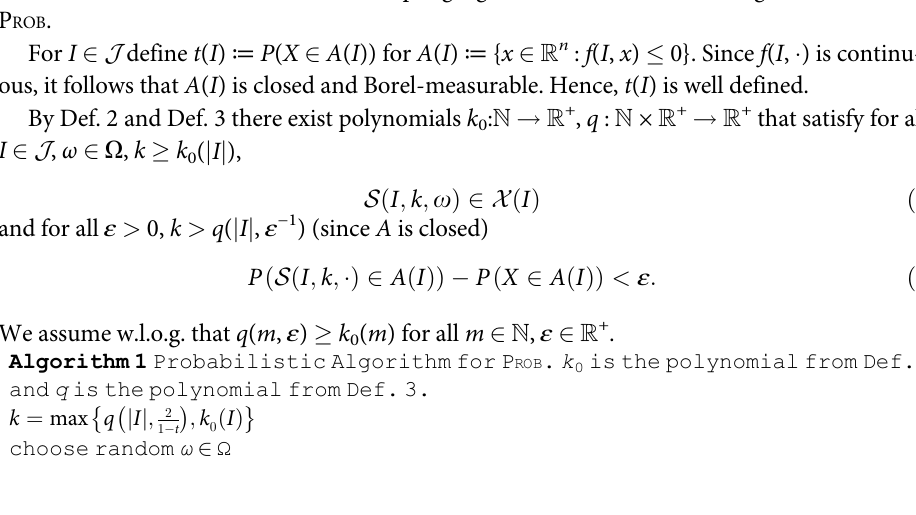
Algorithm 1 Probabilistic Algorithm for P ROB . k 0 is the polynomial from Def. 2 and q is the polynomial from Def.